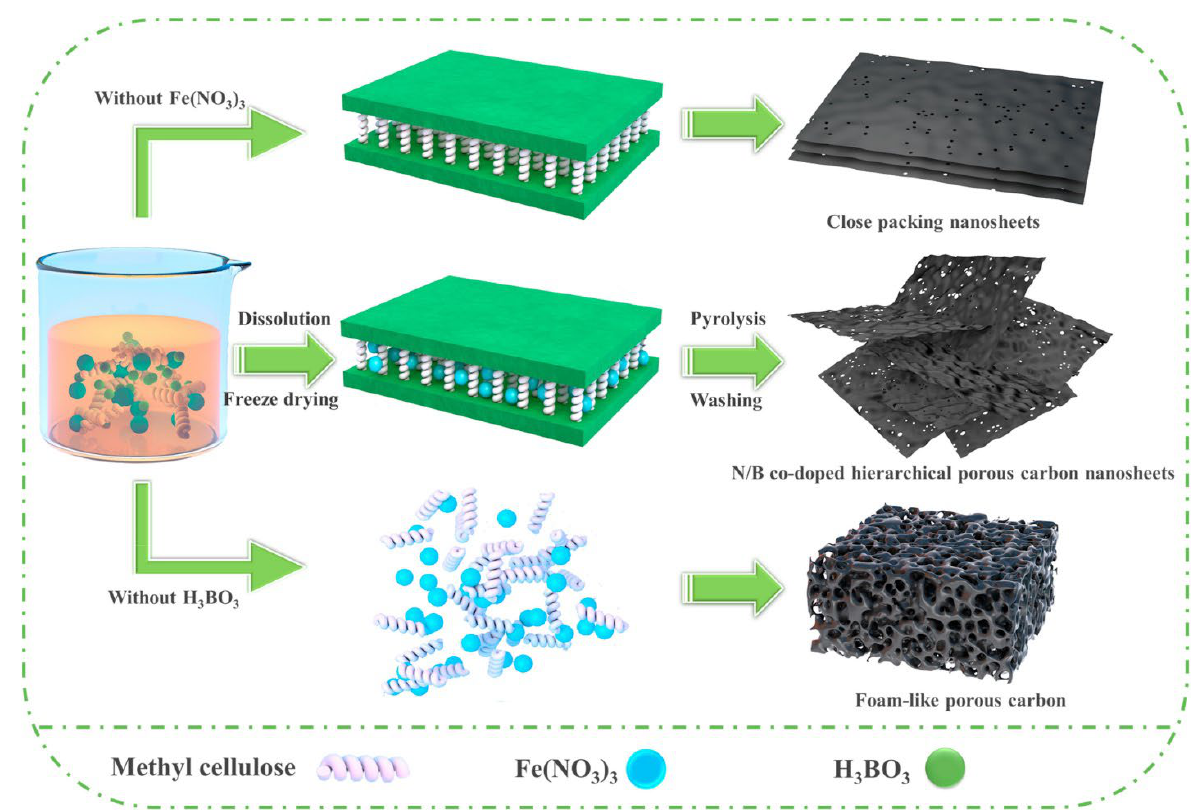
Figure 6. Synthesis of carbon nanosheets via dual template technique. Adapted from reference [36].